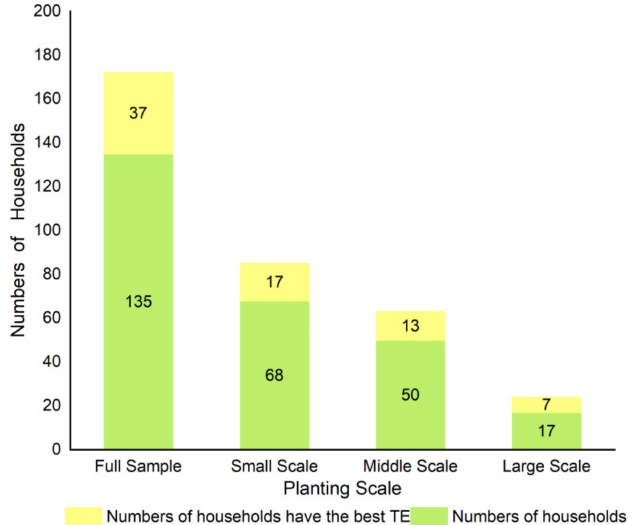
Figure 3. The number of sample farm households of different scales and farm households with the best technical